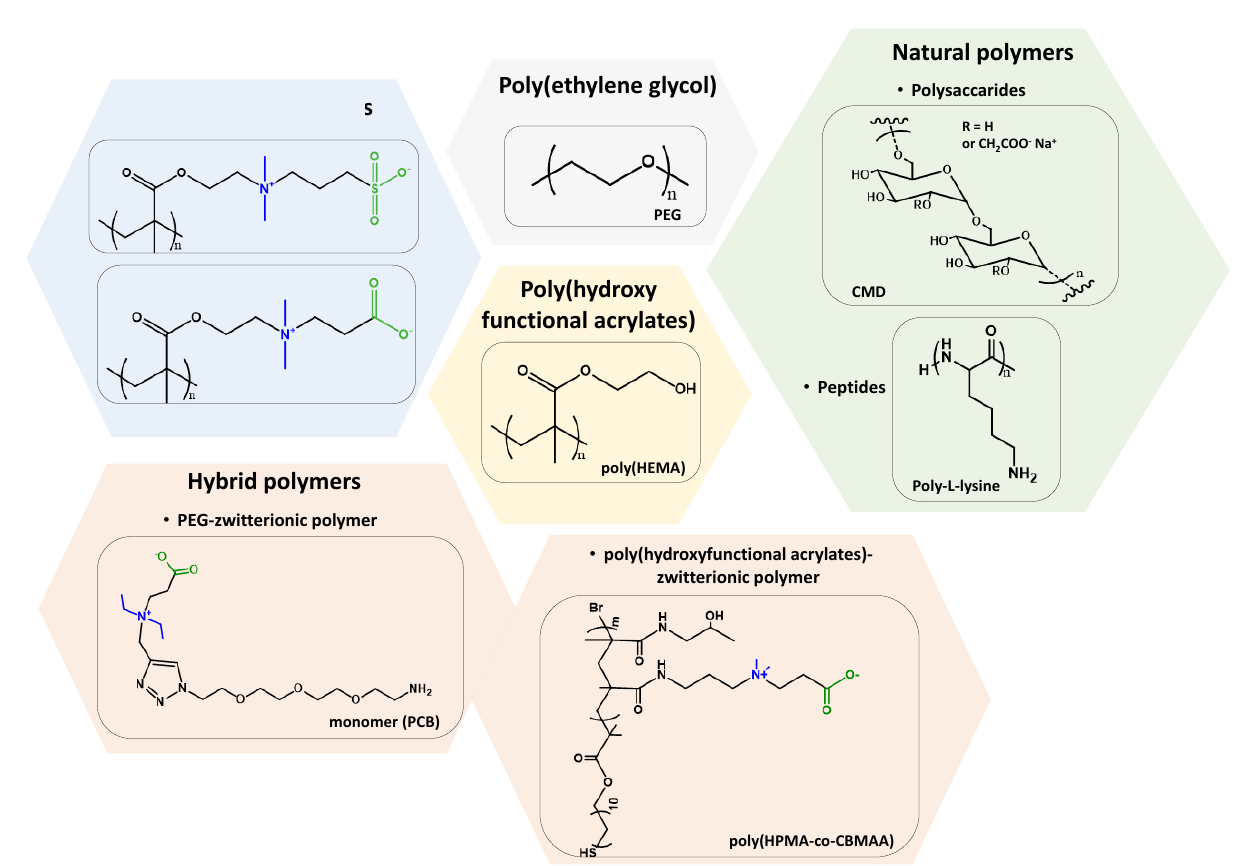
Figure 3. Chemical structure of different layers designed as antifouling coatings.